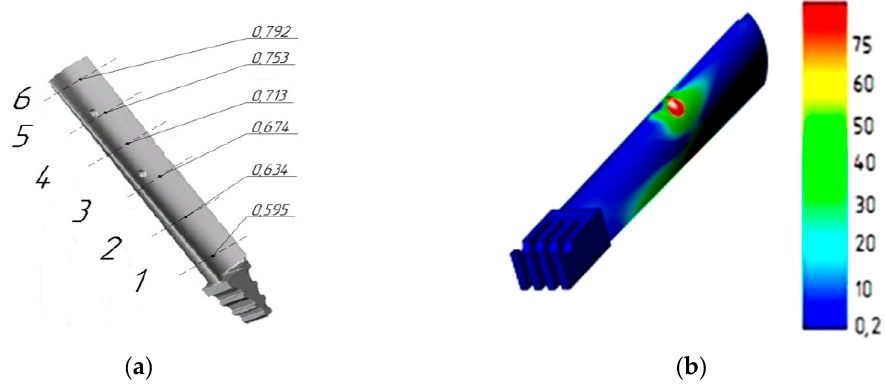
Figure 2. Results of computer modeling in SolidWorks environment: ( a ) Conditional cross-sections of the turbine blade, ( b ) stress distribution in the blade at a load of up to 75 kN.